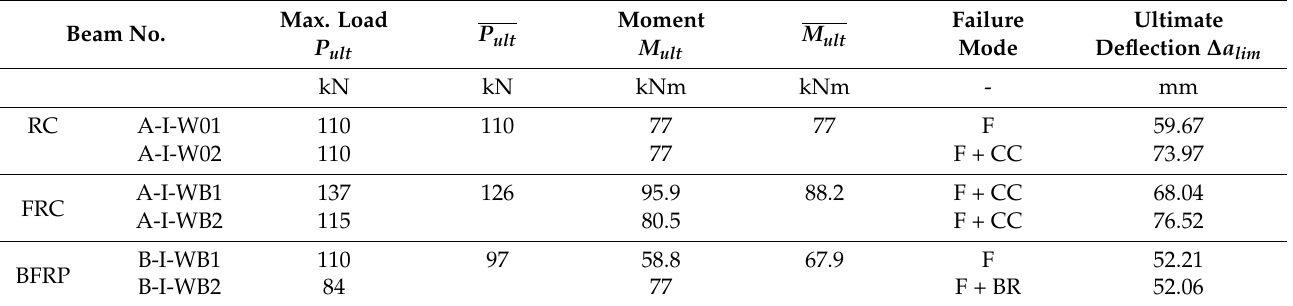
Table 4. Results of tests of beams.